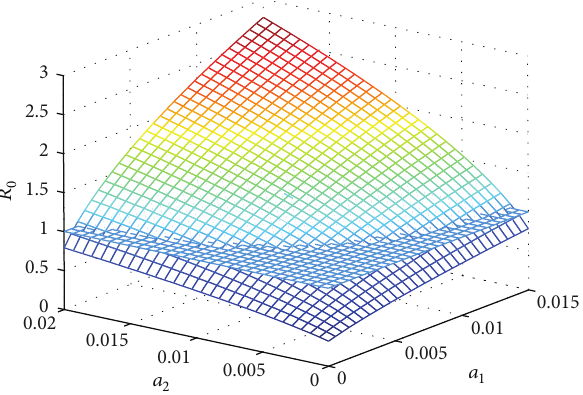
Figure 6: The graph of 𝑅 0 in terms of 𝑎 1 and 𝑎 2 .